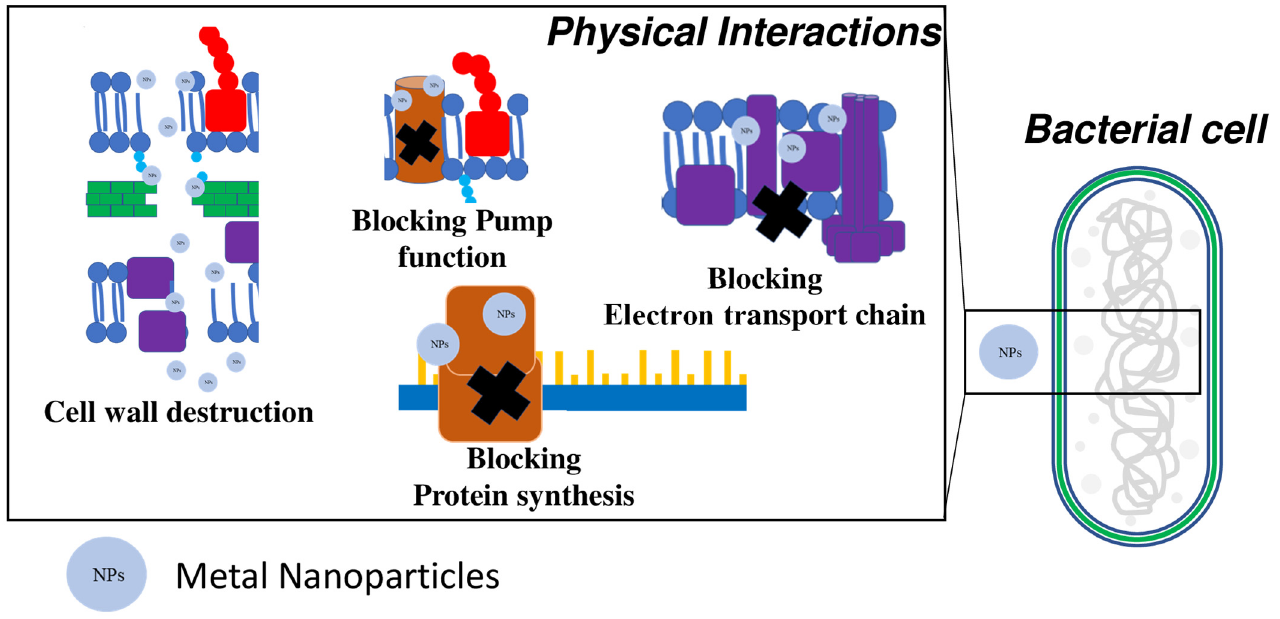
Figure 3. Schematic description and targets of antibacterial mechanisms due to a physical interaction mediated by metal nanoparticles (NPs).